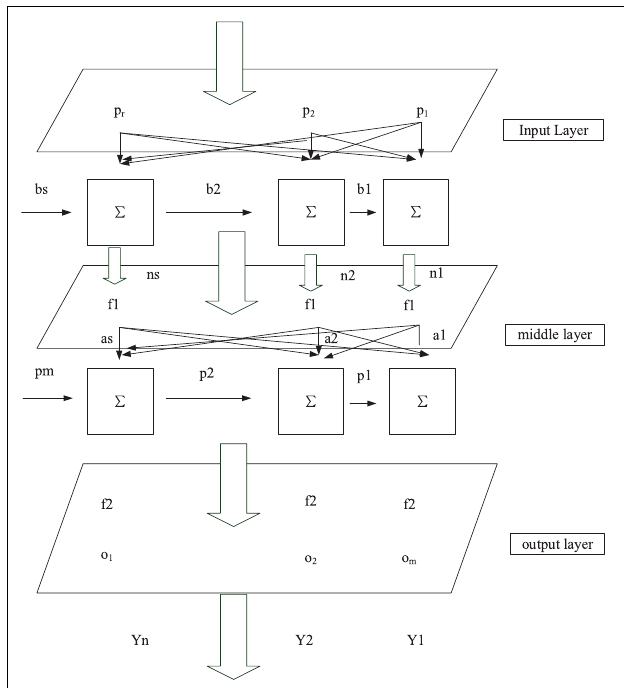
FIGURE 4 | The typical structure of the BPNN model.